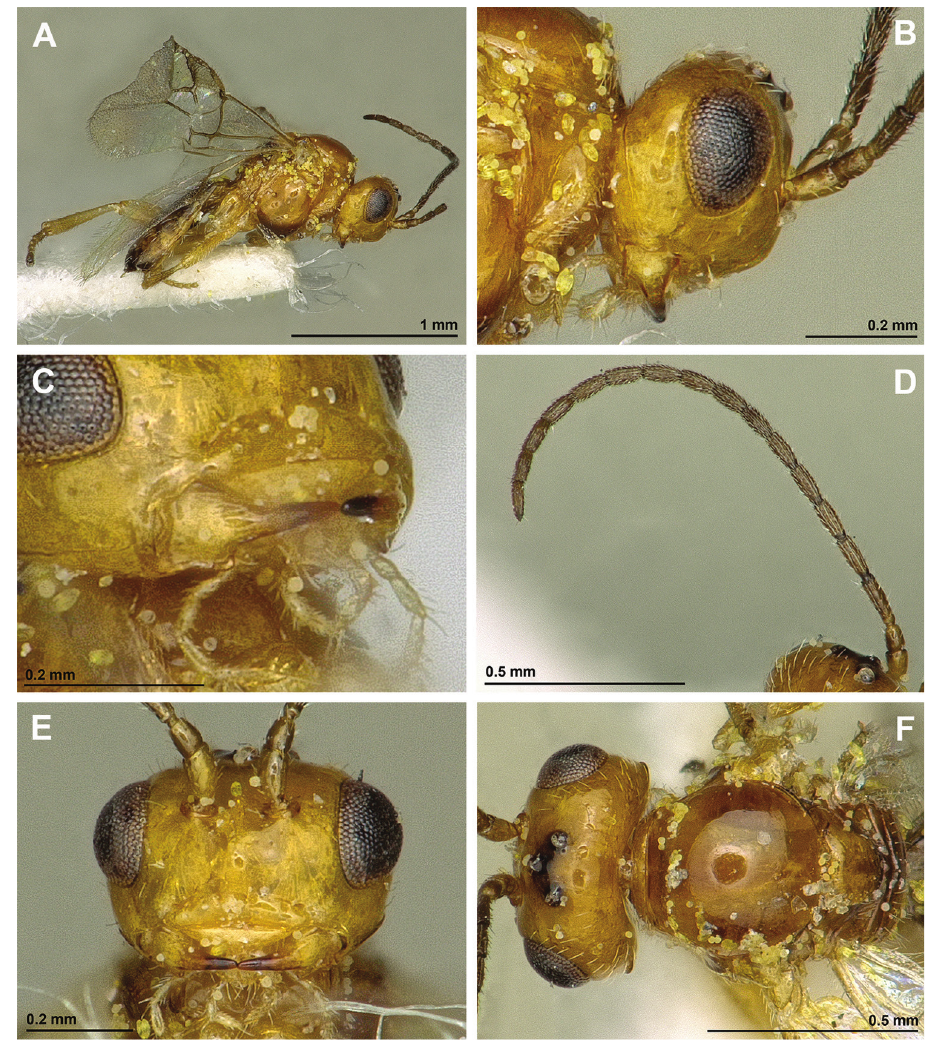
Figure 8. Hoplocrotaphus pospelovi Telenga, 1950 (male, specimen from Turkmenistan) A Habitus, lat- eral view B Head, lateral view C Mandible D Antenna E Head, front view F Head and mesoscutum, dorsal